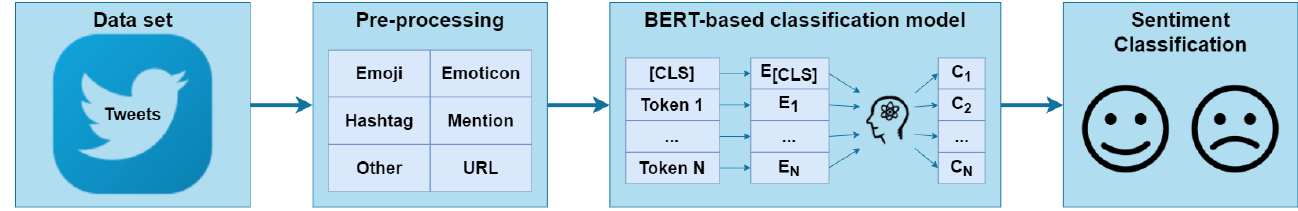
Figure 1. Pipeline overview. [CLS] is the BERT special classification token, E is short for Embedding , and C and T are the final hidden states given by the transformers